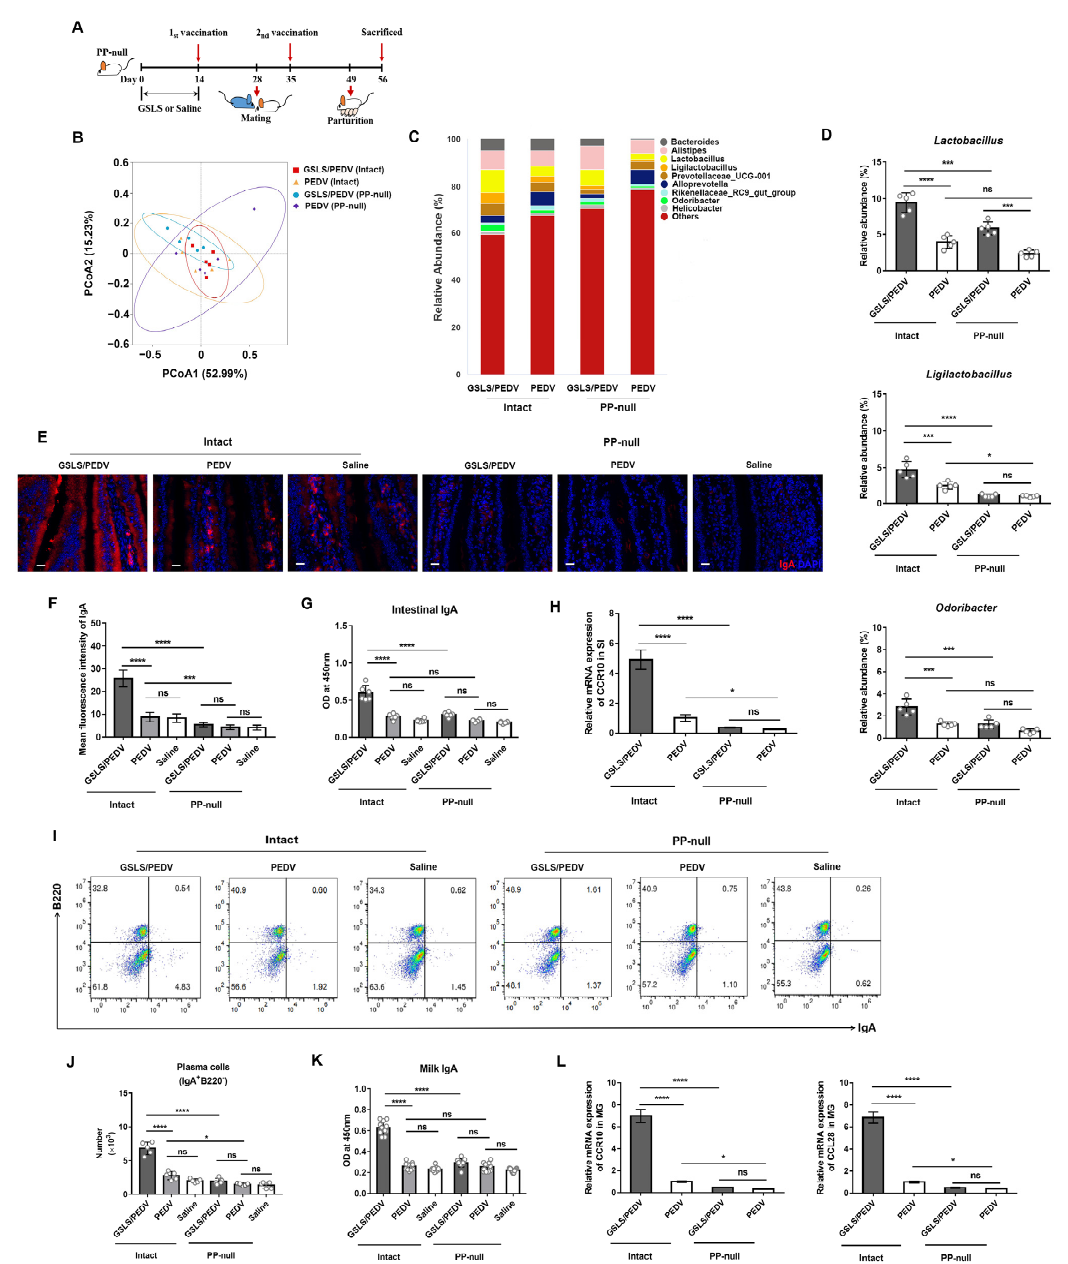
Figure 5. The improvement of the intestinal microbiota and maternal IgA antibody response by GSLS depends on PPs. Normal and PP-null mice ( n = 5/group) were processed as described in Figure 1 and euthanized on day 7 post-partum. ( A ) Experiment scheme. ( B ) PCoA plots of the intestinal micro fl ora genera based on weighted UniFrac distances. ( C ) Relative abundance chart of intestinal fl ora constituents at the genus level. ( D ) Frequencies of Lactobacillus , Ligilactobacillus and Odoribacter